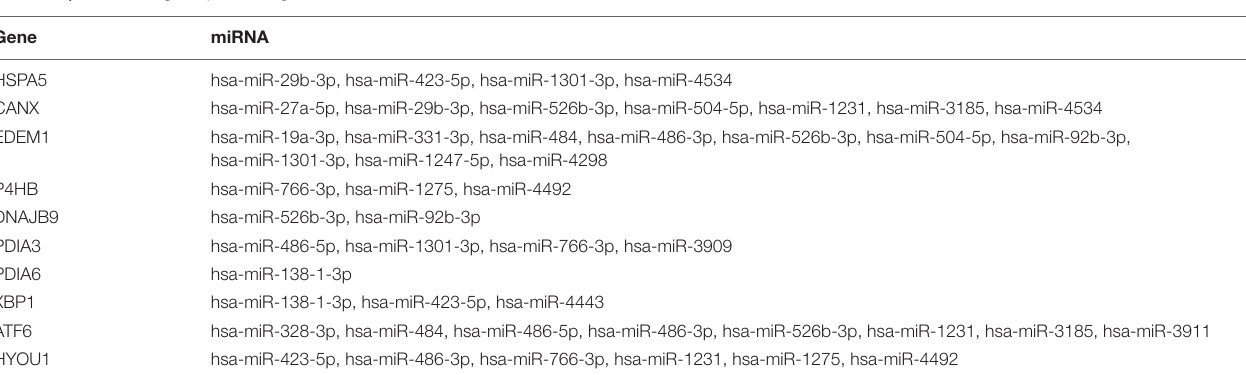
TABLE 3 | miRNAs target top 10 hub genes related to ER